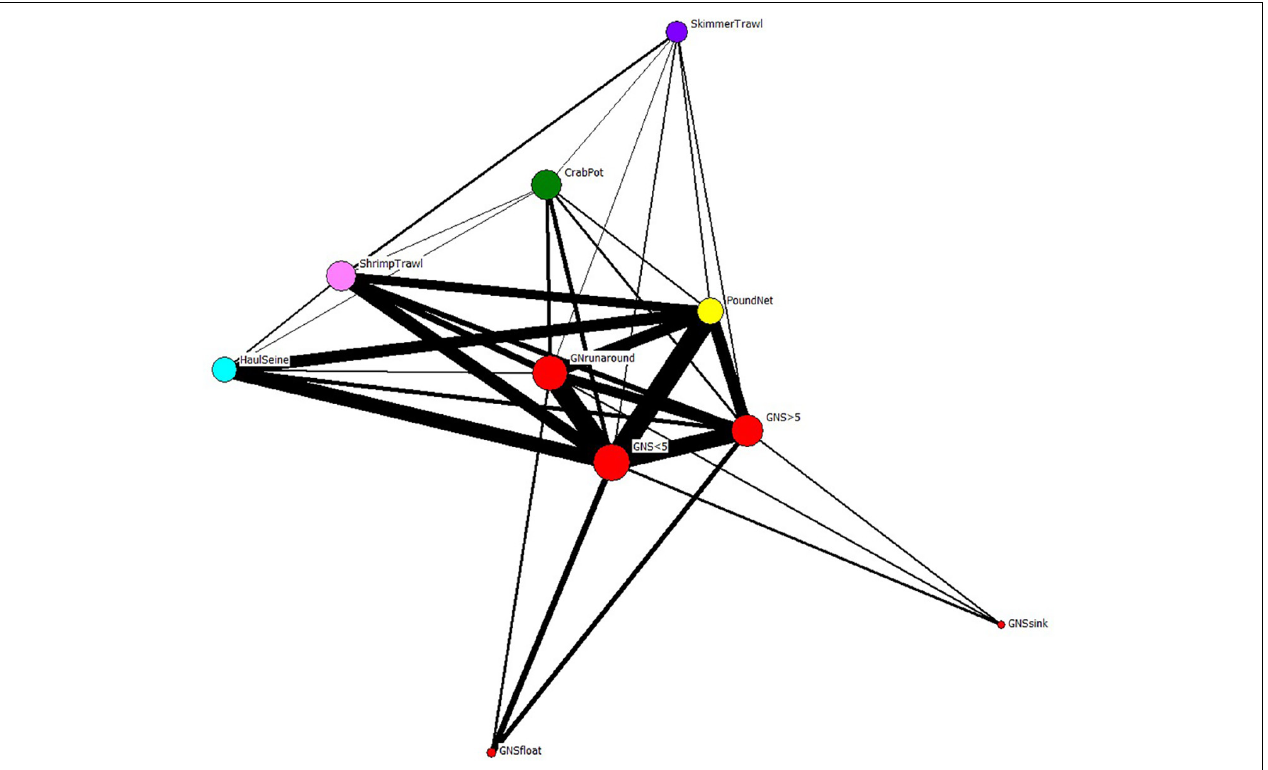
FIGURE 9 | The reduced fisher behavioral network of Core Sound collapsed by gear type. Nodes from each species-gear fishery in Figure 7 were combined into super-nodes by the gear used to catch all species reported by participants. Edge thickness connecting the nodes represents the number of fishery participants that are engaged in the same fisheries (gear types). Node size scaled to Freeman degree centrality. The gear nodes with greatest joint fisher participation were displayed using Fruchterman-Reingold spring-embedder algorithm (Fruchterman and Reingold, 1991), which places high-degree centrality nodes in the center of the